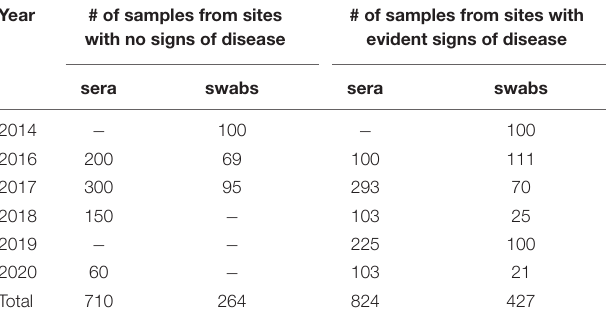
TABLE 1 | Numbers of samples received from production sites.